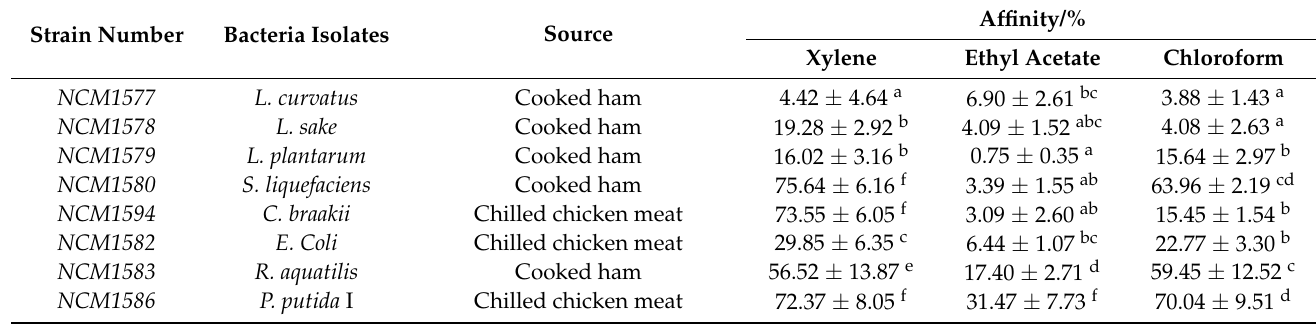
Table 1. Information of 14 isolated strains and their affinity for different